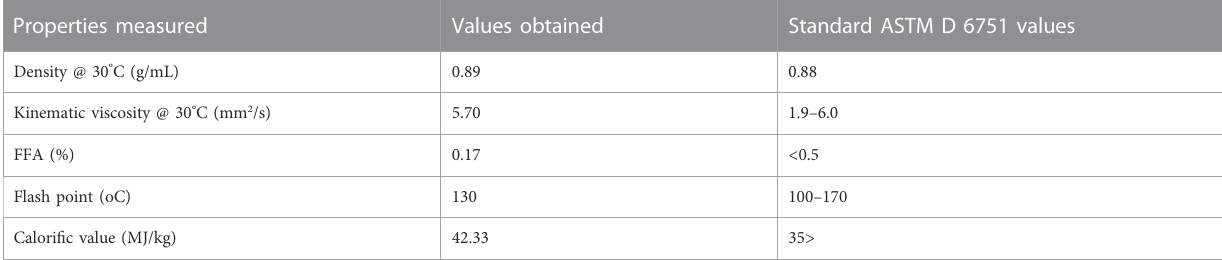
TABLE 3 Physicochemical properties of Jatropha seed oil methyl